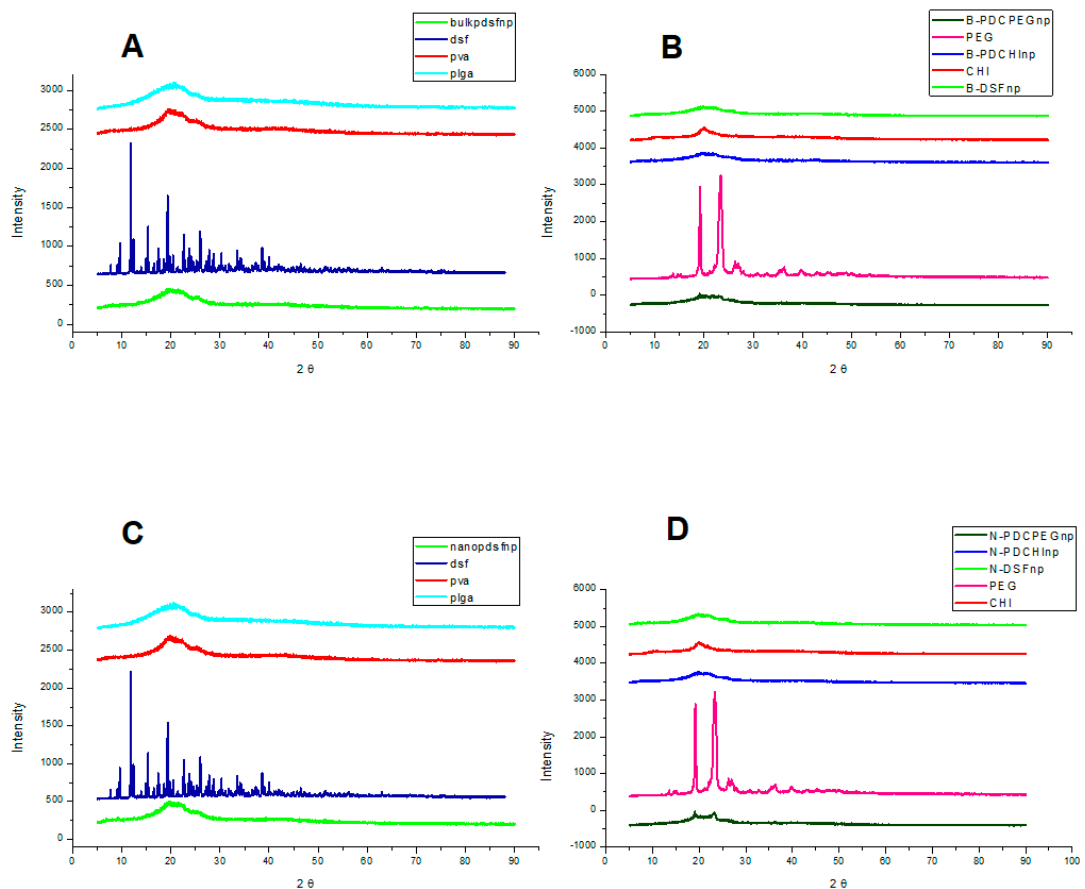
Figure 5. ( A ) and ( B ): X-ray diffraction spectra of the polymers and the loaded nanoparticles (2%